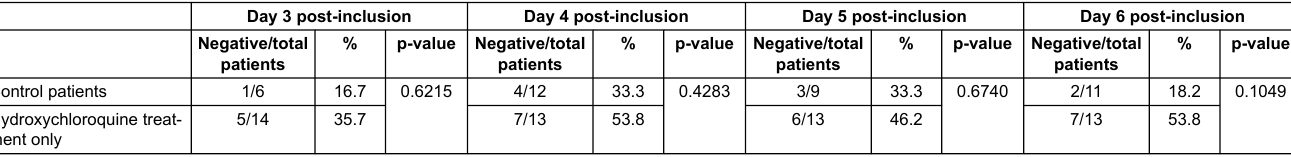
Table S1: Proportion of patients with virological cure in SARS-CoV-2 patients exclusive of all missing datasets. Day 3 post-inclusion